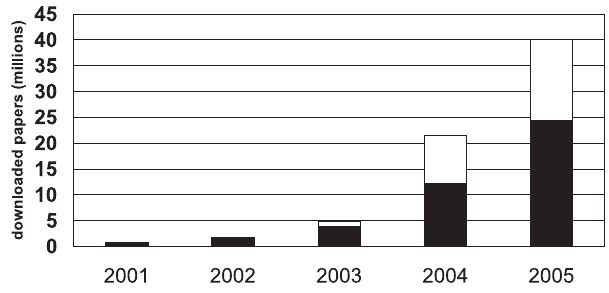
Figure 1 - Downloads from the SciELO site to Third World countries – solid histograms, and to First World countries – hatched histograms (adapted from Greene, LJ, unpublished data)